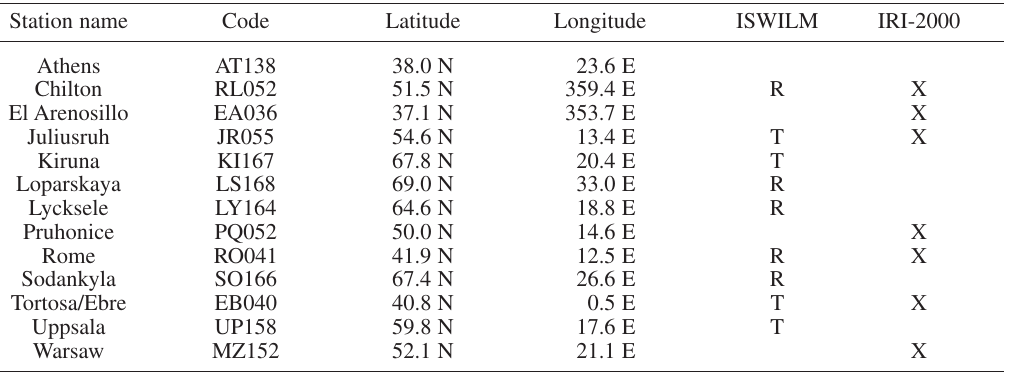
Table 3.I. Ionosonde stations. The ISWILM and IRI-2000 columns indicate the use made of data from the sta- tions in the studies described in sections respectively. Station name Code Latitude